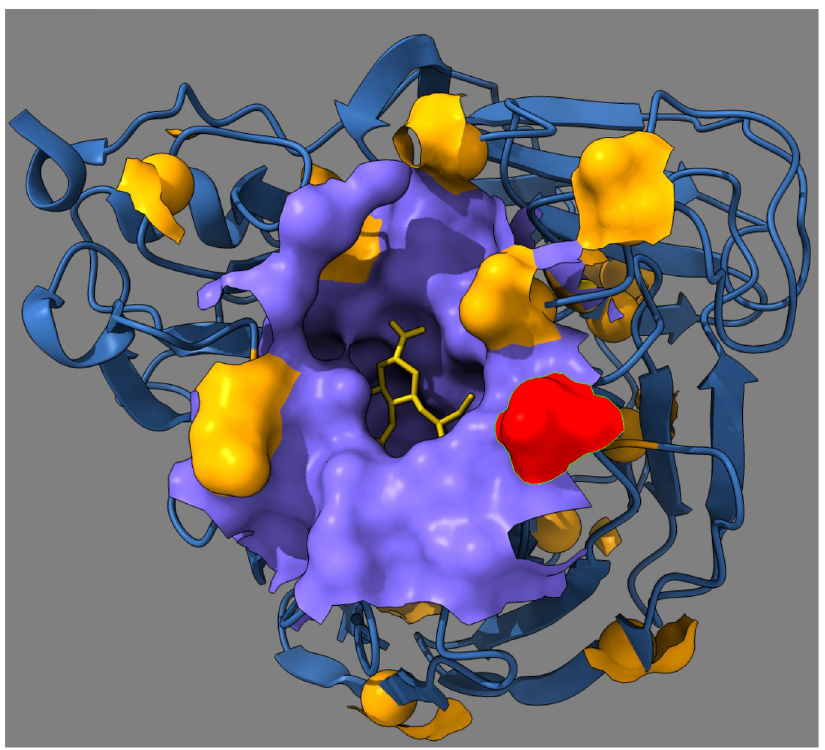
Fig 3. Structural location of the predicted epistasis network for the neuraminidase of influenza virus. The figure shows the three-dimensional structure of Influenza A H1N1 neuraminidase (PDB ID code 4QVZ). Colored spheres represent predicted epistatic residues from Fig 2D. Red sphere: Predicted primary mutation (residue 248 in Fig 2D). Orange spheres: Compensatory residues from Fig 2D.